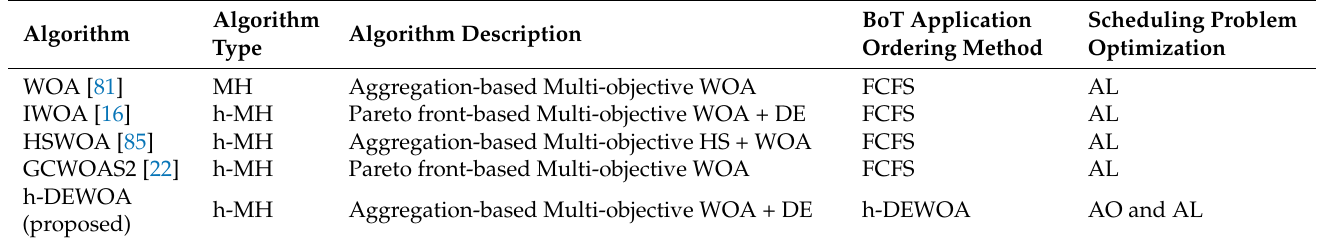
Table 8. Characteristics of WOA-based scheduling